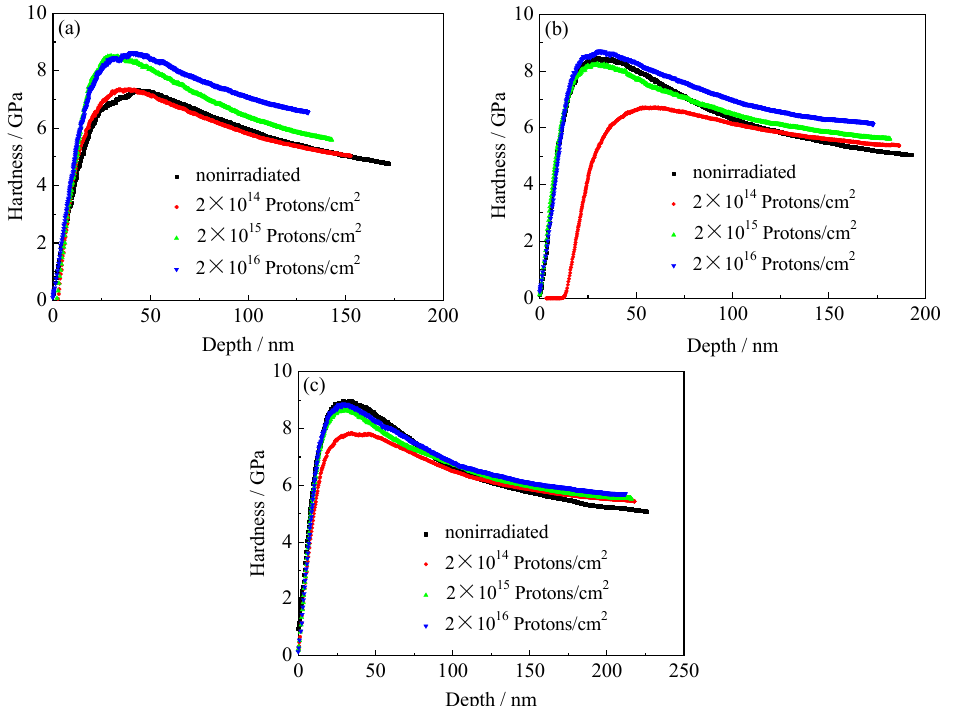
Figure 13. Variation of indentation hardness of tempered 5140 alloy steel tempered at 560 °C with depth under different loads before and after proton irradiation: ( a ) 4000 µN, ( b ) 6000 µN, ( c ) 8000 µN.